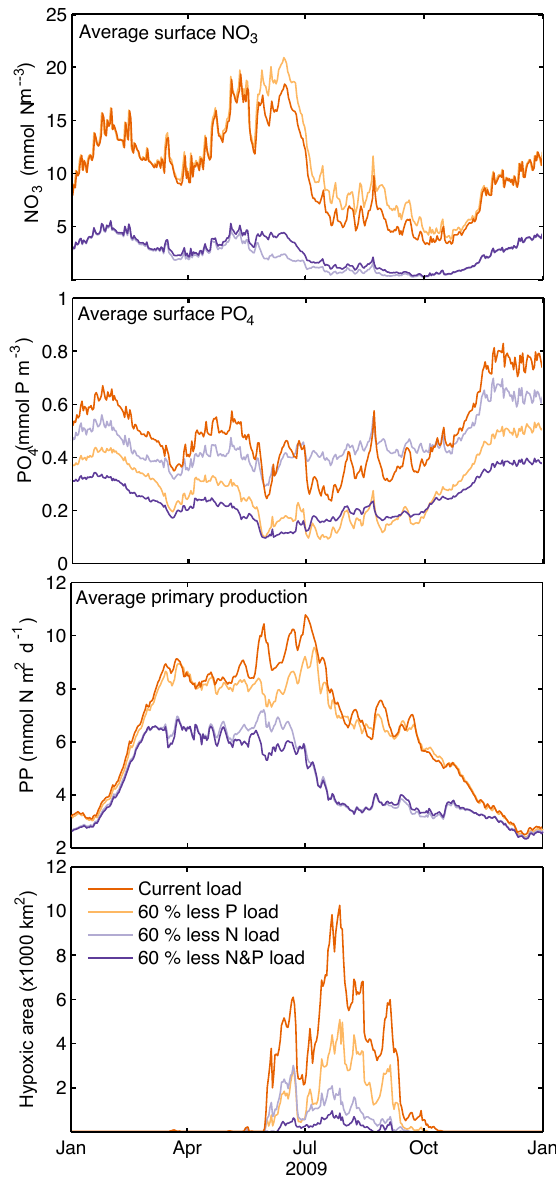
Figure 2. Evolution of shelf-averaged surface nitrate and phosphate concentrations, primary production and bottom-water hypoxic area for 2009 from the simulation with current loads (dark orange), 60% reduction in DIP load (light orange), 60% reduction in TN load (light purple) and 60% in both (dark